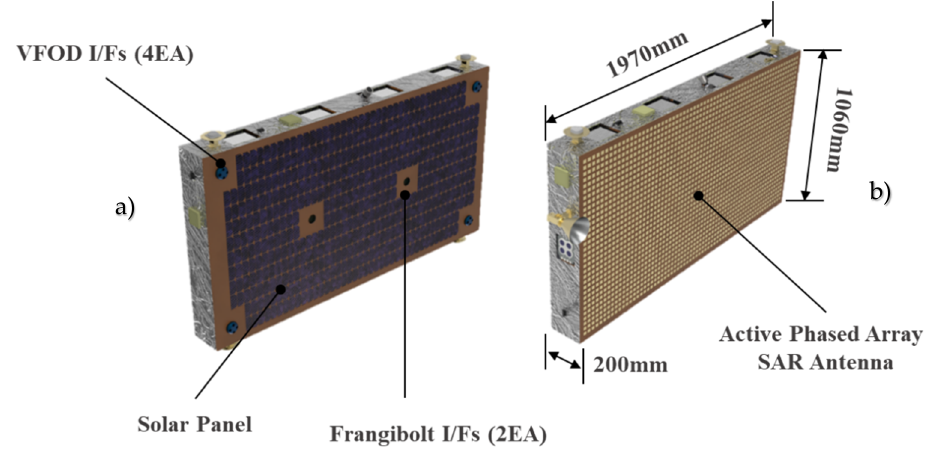
Figure 4. ( a ) Rear ( − z − dir.) and ( b ) front (+ z − dir.) view of the Figure 4. ( a )Rear ( − z − dir.) and ( b )front (+z − dir.) view of the S-STEP.